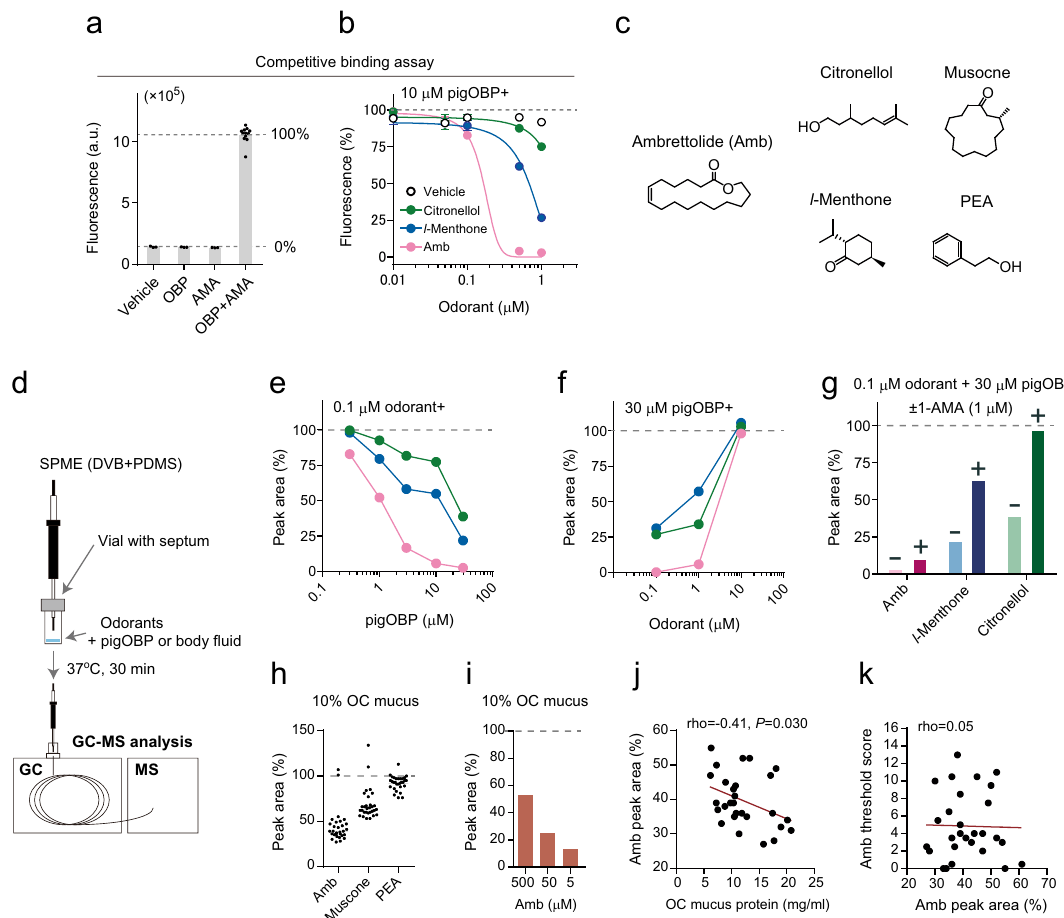
Figure 2. Odorant-capturing property of the olfactory mucus. ( a ) Competitive binding assay for pigOBP to odorants. Data represent fluorescence from vehicle (Tris–HCl), 10 μM pigOBP, 1 μM 1-AMA, and their mixture. ( b ) Change in fluorescence when pigOBP-1-AMA complex was exposed to increasing concentrations of odorants. Fluorescence was normalized using values from the vehicle and mixture of pigOBP and 1-AMA. Error bars, standard deviation over three replicates. ( c ) Chemical structures of odorants. ( d ) Experimental procedure for the quantification of odorant-binding capacity based on headspace concentrations of odorants. ( e , f ) Odorant-capturing capacity of pigOBP. Three odorants emitted from pigOBP solution were extracted and analyzed with SPME-GC/MS. ( e ) pigOBP reduced the release of odorants from a solution in a dose- and affinity-dependent manner. ( f ) Odorant-capturing properties of 30 μM pigOBP depending on odorant concentration. ( g ) Addition of 1-AMA-induced release of odorants from pigOBP solution. Data are shown as percent peak area, where the detected peak area from odorant solution without pigOBP was set to 100%. ( h ) Individual variance of the odorant-capturing capacity of OC mucus. Relative headspace concentration of odorants emitted from × 10 diluted OC mucus. Odorants were added with ethanol for a final concentration of 500 µM. The peak area of each odorant without OC mucus was set to 100% after normalization with the peak area of ethanol. ( i ) Odorant-concentration dependence of the capacity of the OC mucus. Relative headspace concentration of odorants emitted from × 10 diluted OC mucus (5–500 μM for final concentrations). ( j ) Correlation of odorant-capturing capacity and protein concentration of the OC mucus (n = 28). ( k ) Association between odorant-capturing capacity and perceptual sensitivity to Amb. OBP, odorant binding protein; PEA,